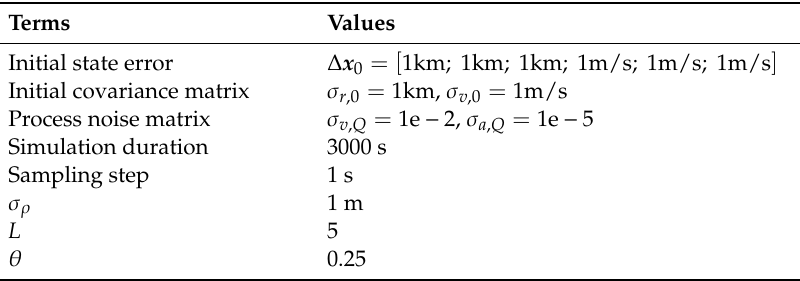
Table 1. The initial condition of parameters in the simulation.